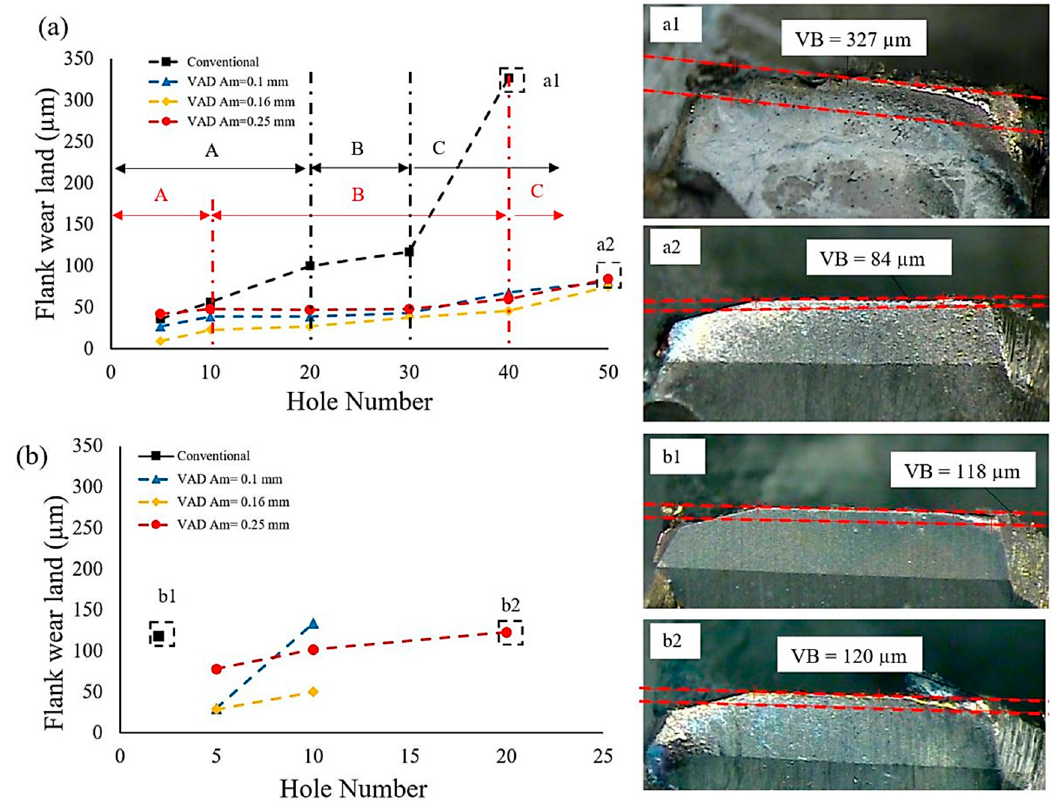
Figure 8. The e ff ect of vibration amplitude on the tool flank land wear for N = 56.52 m / min: Figure 8. The effect of vibration amplitude on the tool flank land wear for N = 56.52 m/min: ( a ) f = ( a ) f = 0.025 mm / rev and ( b ) f = 0.075 mm / 0.025 mm/rev and ( b ) f = 0.075 mm/rev.